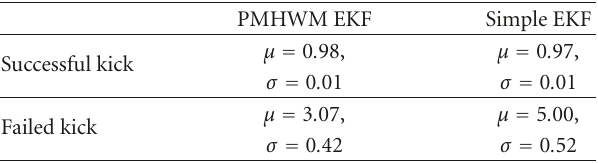
Table 7: Mean times (in seconds) and standard deviations to find the ball after successful and unsuccessful kicks. Finding the ball after a successful kick was statistically the same time while finding the ball after an unsuccessful kick was statistically much faster with the PMHWM approach. PMHWM EKF Simple